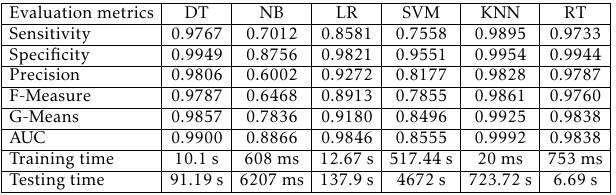
Table 2. Results of using single classifier when classifying DoS on UNSW-NB15